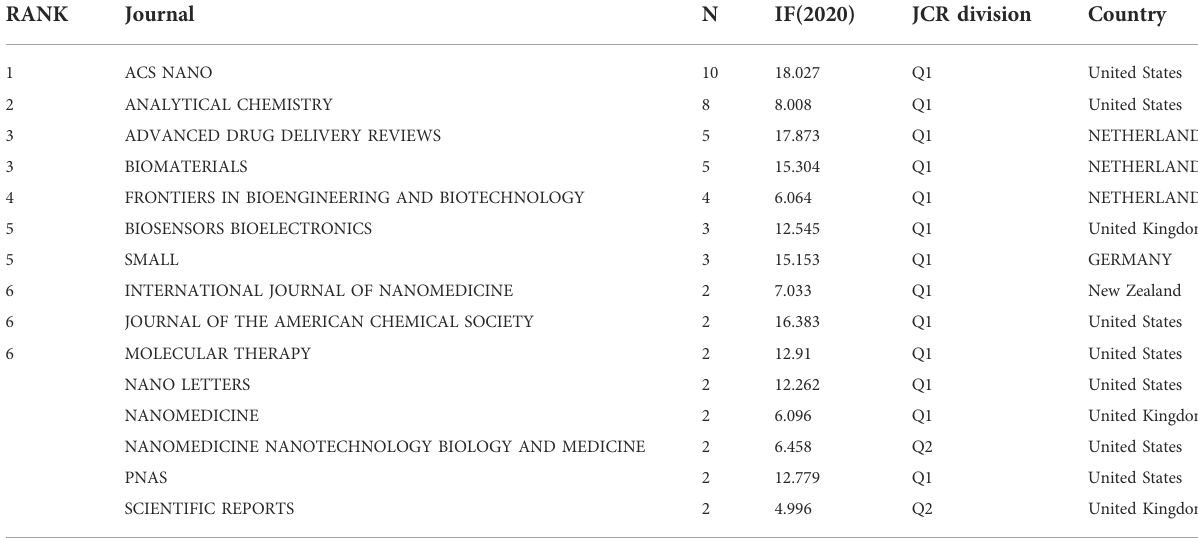
TABLE 7 The top 10 journals of top100 cited articles